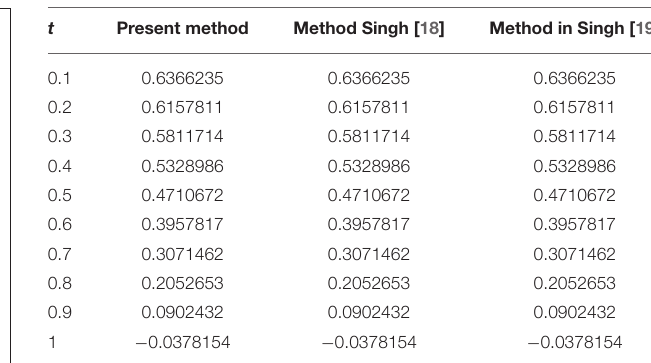
TABLE 2 | Comparison with the methods of Singh [18, 19] at α Liénard